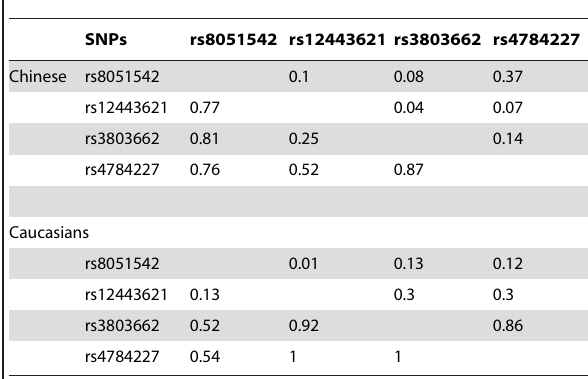
D 9 : Lower left triangle. r2: Upper right